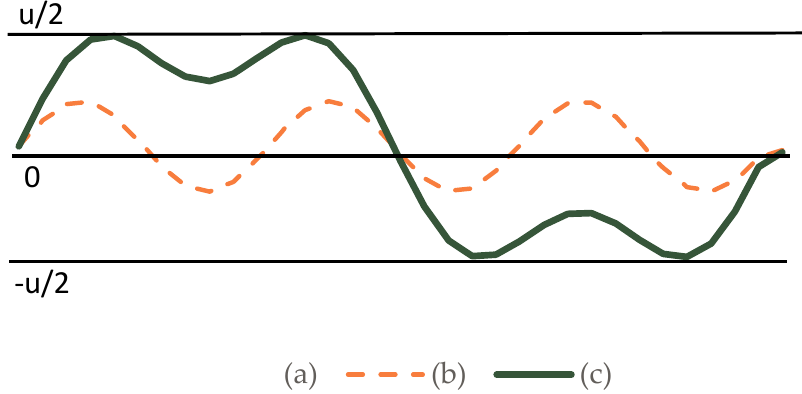
Figure 9. The graph of optimization signals: ( a ) the fundamental sinusoid, ( b ) the third harmonic of fundamental sinusoid, ( c ) the optimized reference sinusoid.